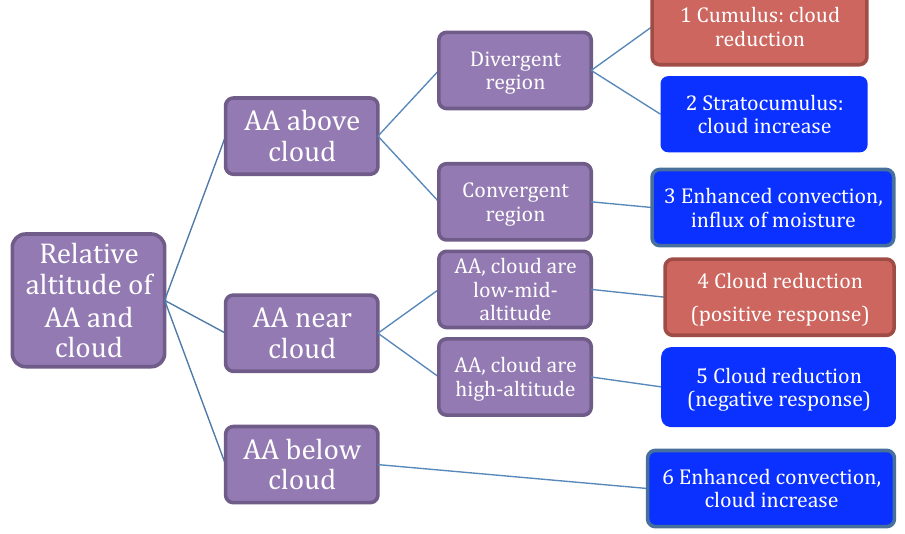
Fig. 1. Suggested framework to organize aerosol absorption effects on cloud cover. Red and blue indicate positive and negative semi-direct